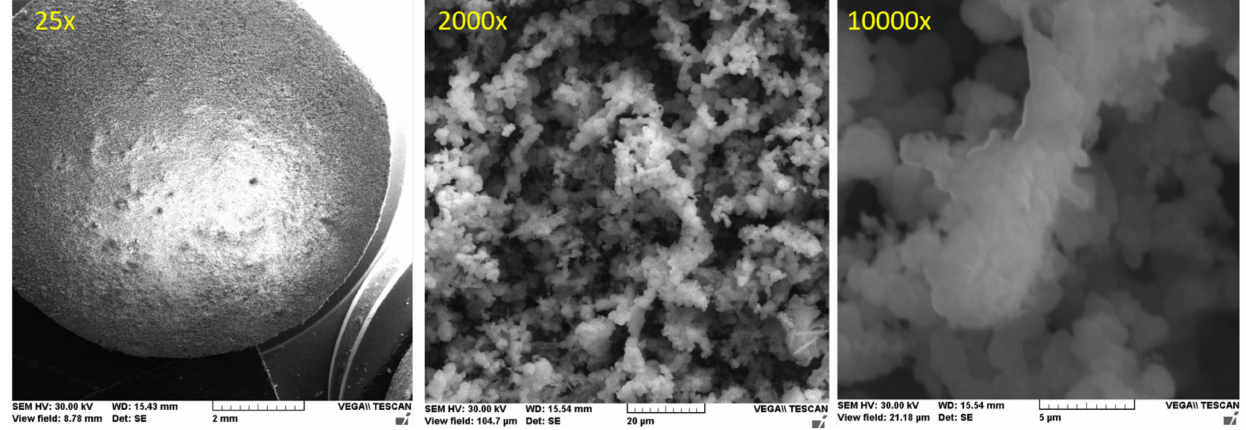
Figure 18. SEM micrographs for cast iron samples were maintained for 65 days in